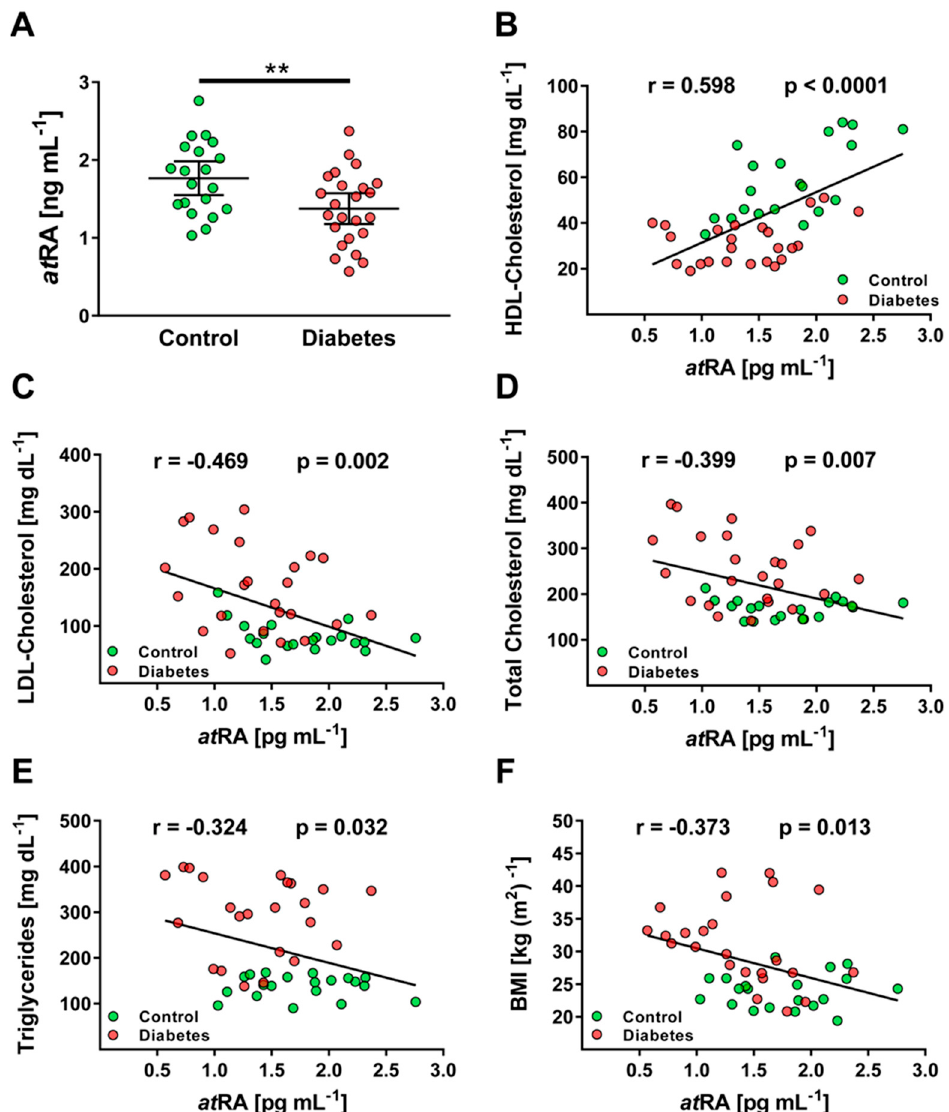
Figure 3. Clinical application and associations with lipid profile in human plasma samples. ( A ) Quantification of at RA in control patients ( n = 20) and patients with Type 2 diabetes ( n = 24). Correlation analysis of ( B ) at RA and HDL cholesterol, ( C ) at RA and LDL cholesterol, ( D ) at RA and total cholesterol, ( E ) at RA and triglycerides, and ( F ) at RA and BMI. ( B – F ) Correlation analysis was performed in the whole cohort. Level of significance and Pearson’s correlation coefficient (r) are shown. Data are mean ± SEM. ** p < 0.01.